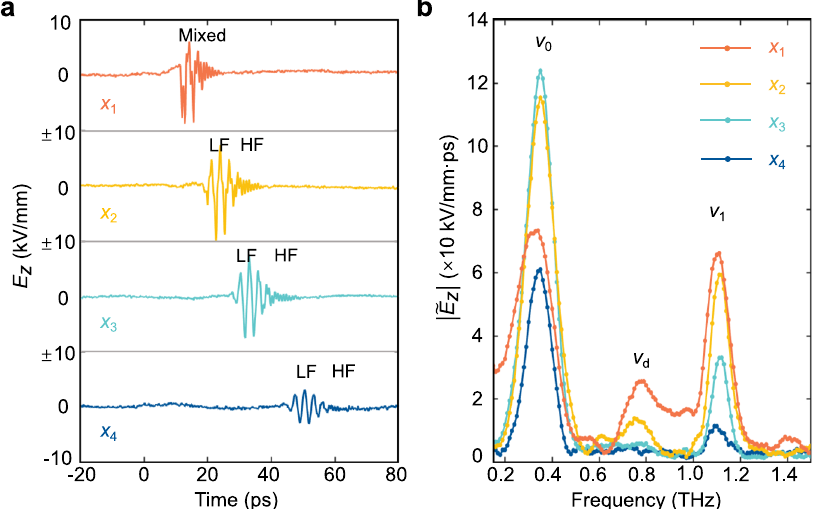
Fig. 4 Evolution of the THz optical fi eld with time at different positions and their corresponding Fourier spectra. a The fi eld oscillation of THz waves as a function of time at various positions of x 1 = 1.18 mm, x 1 = 1.82 mm, x 1 = 2.39 mm and x 1 = 3.44 mm relative to the position where THz waves are generated. LF and HF indicate the lower and higher frequency components which also show their walk-off during propagation. b Corresponding Fourier spectra of the matched THz waves at frequencies v 0 and v 1 , as well as their DFG signal at the four